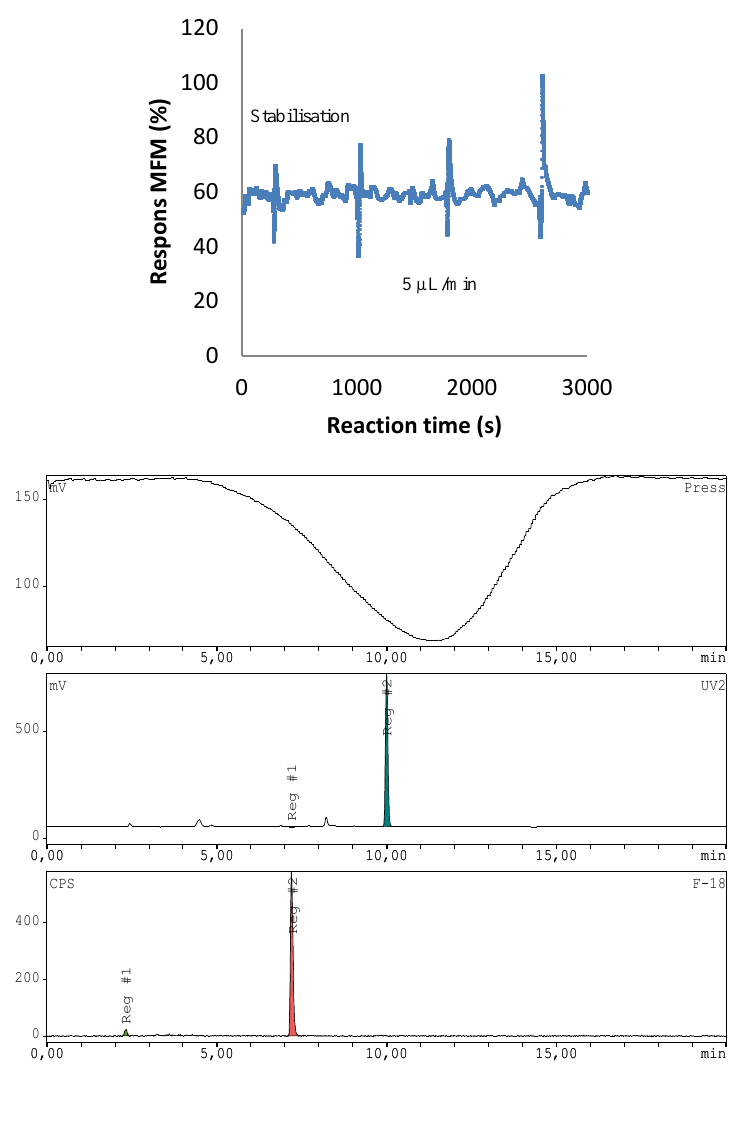
Figure 11. Flow metering of the synthesis of